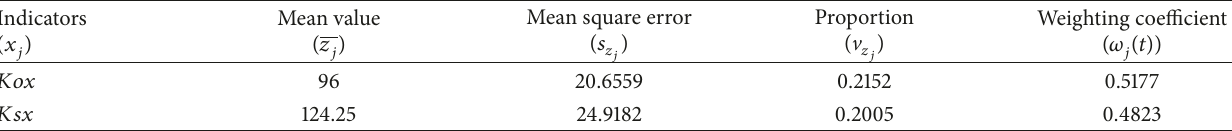
Table 5: The weighting coefficient of residual life of 𝐾𝑜𝑥 and 𝐾𝑠𝑥.